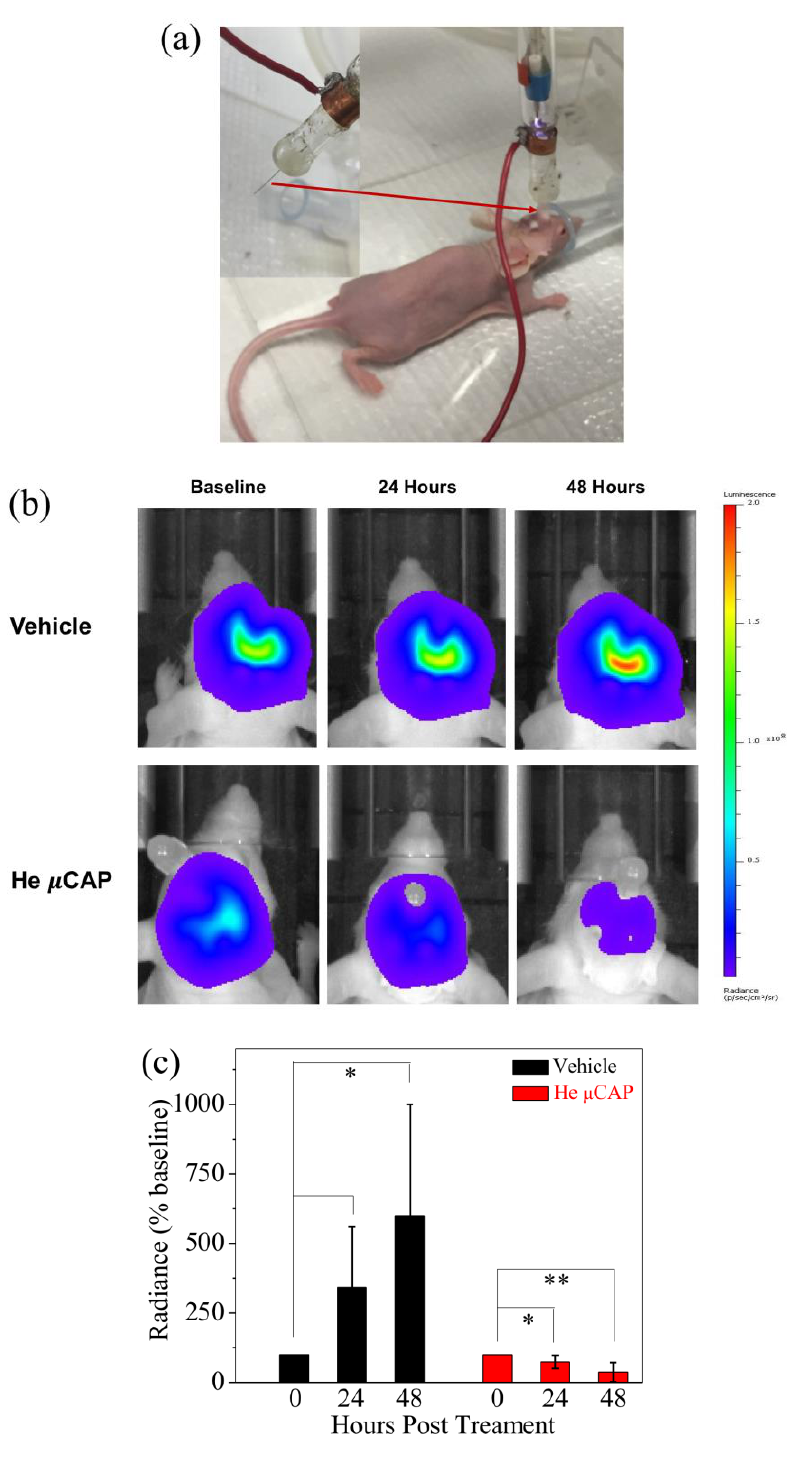
Figure 7. In vivo targeting of glioblastoma tumor with He µCAP. ( a ) Photograph of a new μCAP device for plasma delivery through an intracranial endoscopic tube to target glioblastoma tumors in the mouse brain; ( b ) Representative in vivo bioluminescence images illustrating glioblastoma tumor volume (i.e., light emission or radiance) at baseline and 2 days following He µCAP or vehicle (helium) treatment. Areas of high photon emission are shown in red and low are shown in blue; ( c ) Group summary data ( n = 3/group) indicates that the tumor volume in control aggressively increased following treatment, whereas He µCAP delivery maintained tumor volume below basal levels.